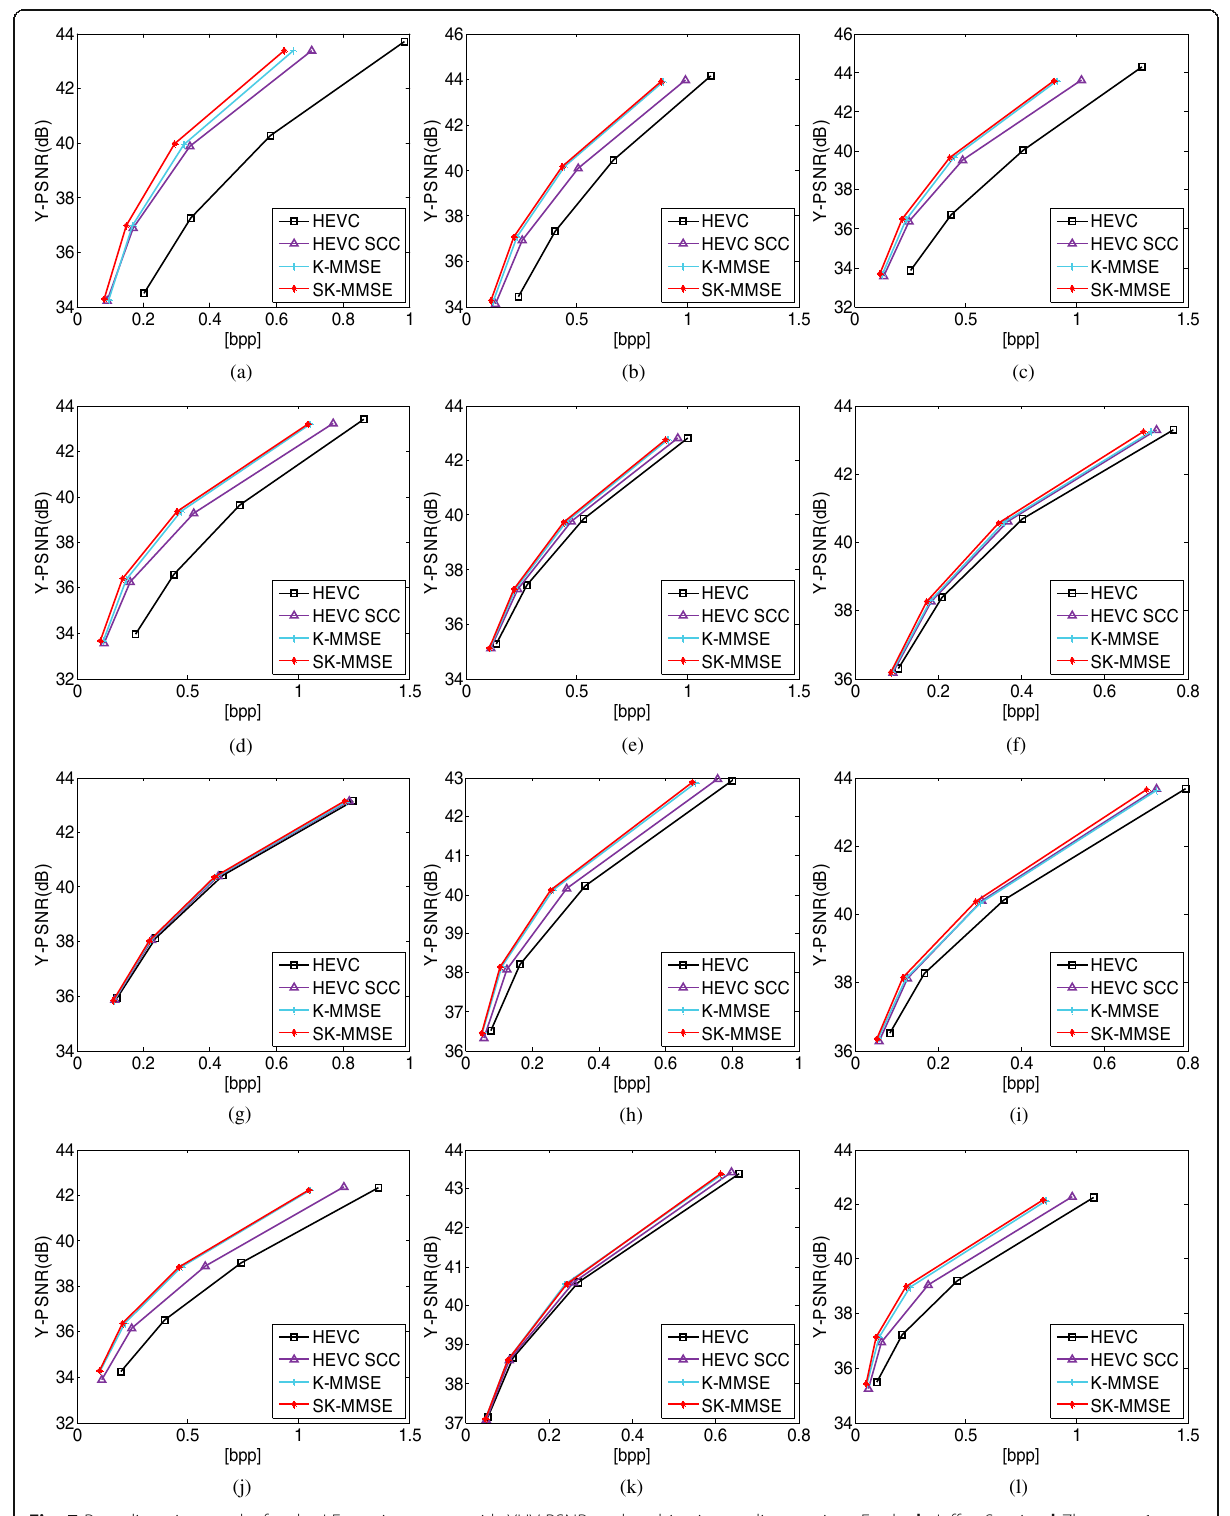
Fig. 7 Rate-distortion results for the LF test image set with YUV-PSNR as the objective quality metric. a Fredo, b Jeff, c Sergio, d Zhengyun1,